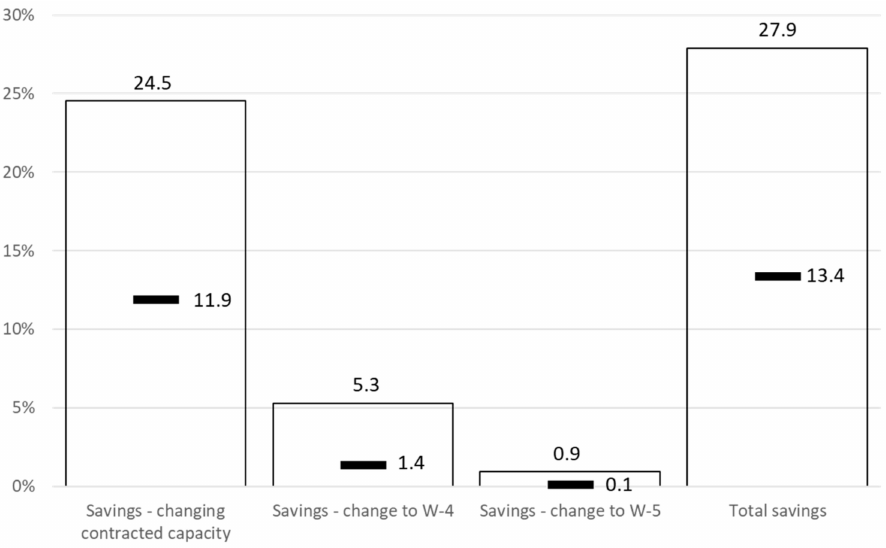
Figure 3. Minimum, average, and maximum level of savings within a given category—gas. The group of costs related to contracted capacity has the largest share in the total amount. Savings in this group amount to PLN 519 thousand, and the second largest of savings is the group of costs related to the change of the tariff group to W-4 (PLN 59 thousand). The savings that can be obtained in individual communes are presented below (Figure 4).